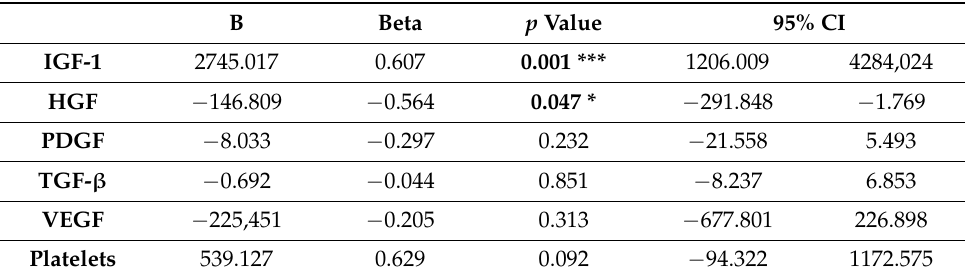
Table 4. Multivariate regression analysis for cell proliferation at 96 h.